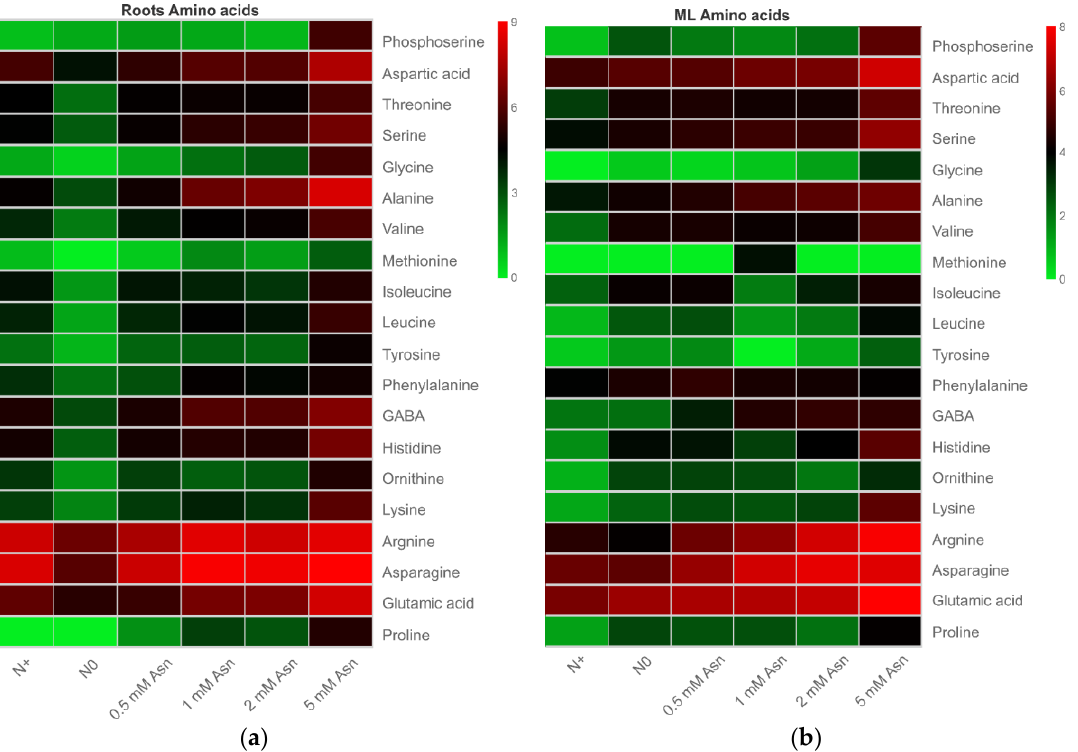
Figure 4. Nitrogen utilization efficiency (NUtE) ( a ) and nitrogen uptake efficiency (NUpE) ( b ) of poplar ‘Nanlin89 5 ’ under different asparagine (Asn) treatment. “N0” indicates N - free; “N+” repre- sents the inorganic N control. The concentration of Asn applied was 0.5 mM, 1 mM, and 2 mM as indicated. Bars denote me ans ± SD (n ≥ 3), and different letters indicate significant differences ( p < 0.05) based on Duncan’s test.